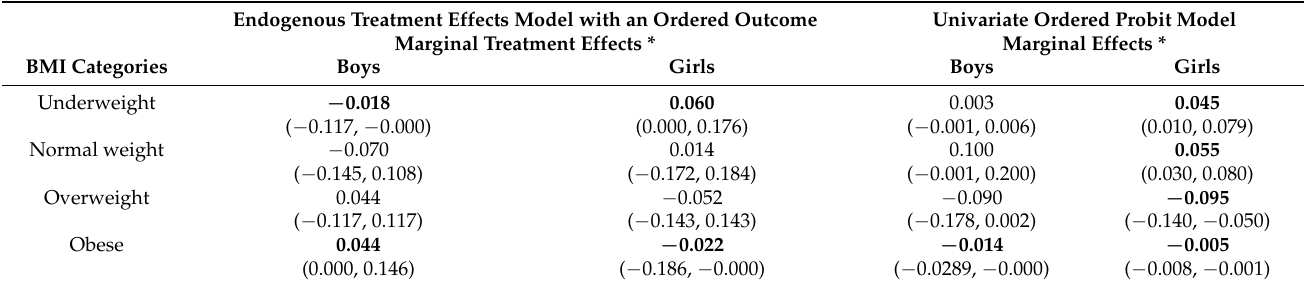
Table 6. Marginal effects of smoking on adolescents’